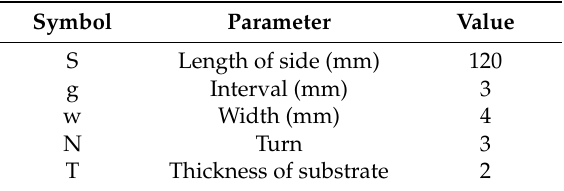
Figure 7. ( a ) The structure of the MM unit cell. ( b ) The relative permeability versus the frequency of the MM unit cell. Table 1. The structure parameters of the MM unit cell.